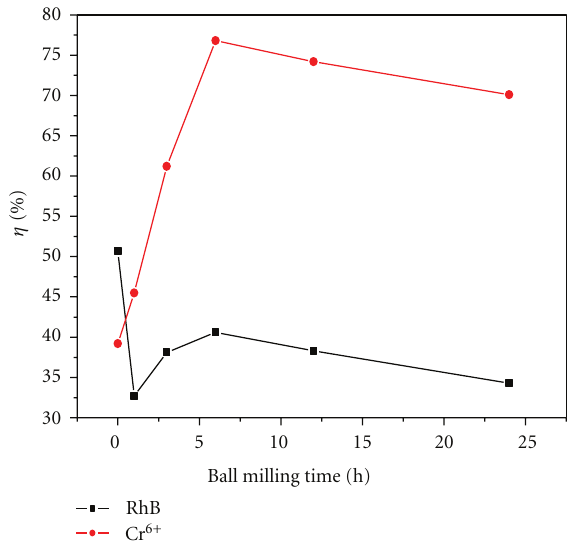
Figure 8: E ff ect of ball milling time on the photocatalytic activity.